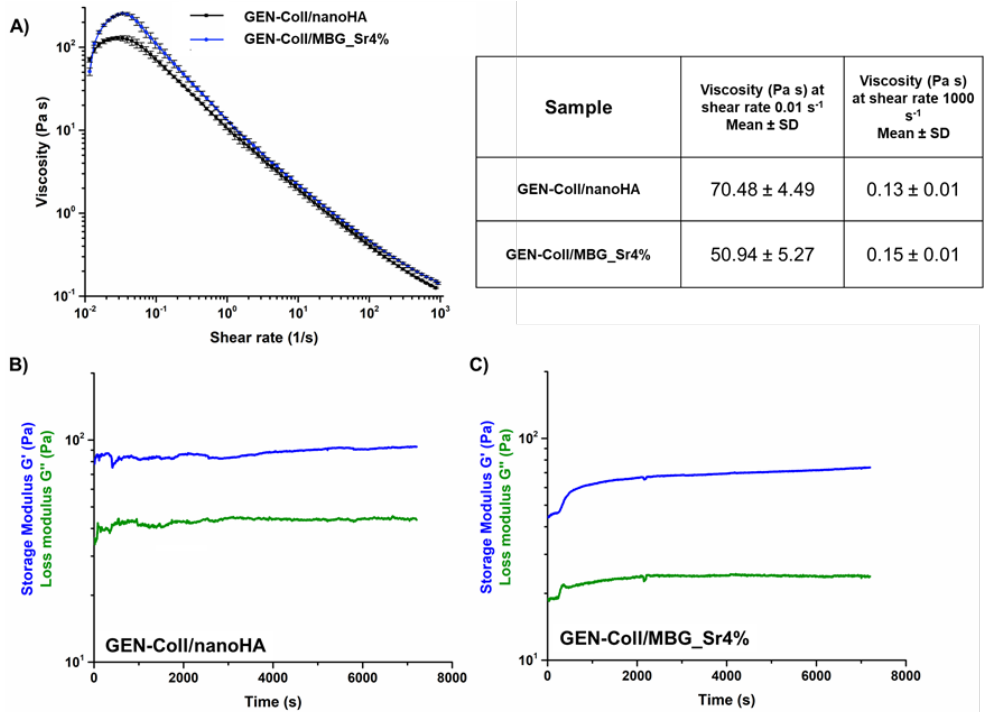
Figure 3. Variation of the viscosity ( A ), and visco-elastic properties of GEN-Coll/nanoHA ( B ) and GEN-Coll/MBG_Sr4%, ( C ) at 10 °C.